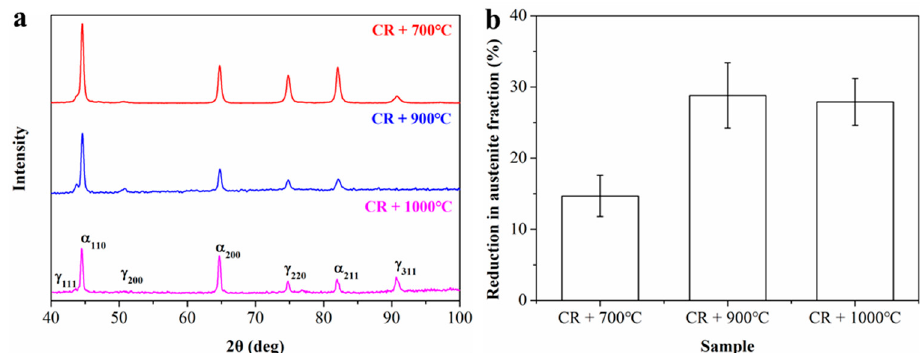
Figure 5. ( a ) Representative XRD spectrums and ( b ) the corresponding quantified results of annealed samples after tensile testing to failure.